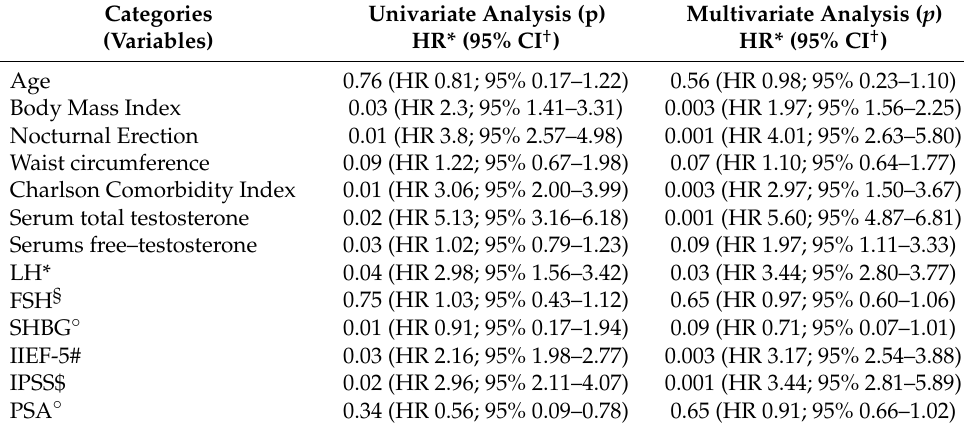
Table 2. Univariate and multivariate analysis results of laboratory and clinical factors affecting testosterone replace treatment need in 141 patients enrolled in the training